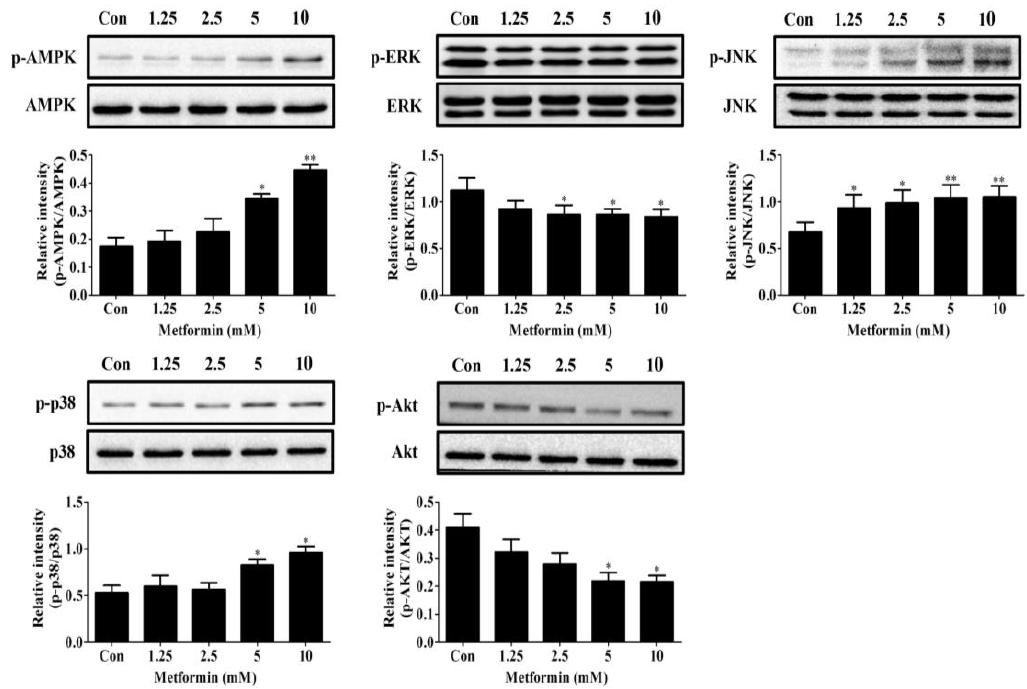
Figure 6. Dose response of 1.25 – 10 mM of metformin on phosphorylation of AMPK, Akt, and MAPKs in 3T3-L1 preadipocytes. Cells were cultured in differentiation medium containing 0, 1.25, 2.5, 5, or 10 mM of metformin for 15 min to examine AMPK, p38, JNK, and Akt activation and for 30 min to examine ERK activation. Results were quantified using densitometry analysis and normalized to total MAPKs, Akt, or AMPK accordingly ( n = 3). Data represent the means ± SEM from three experiments. * p < 0.05 and ** p < 0.01 as compared with control (DMI alone) cells (one-way ANOVA with Dunnett’s correction).